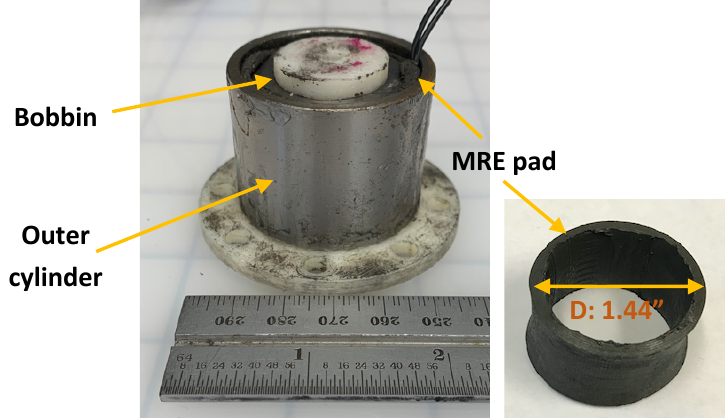
Figure 5. Photograph of the fabricated